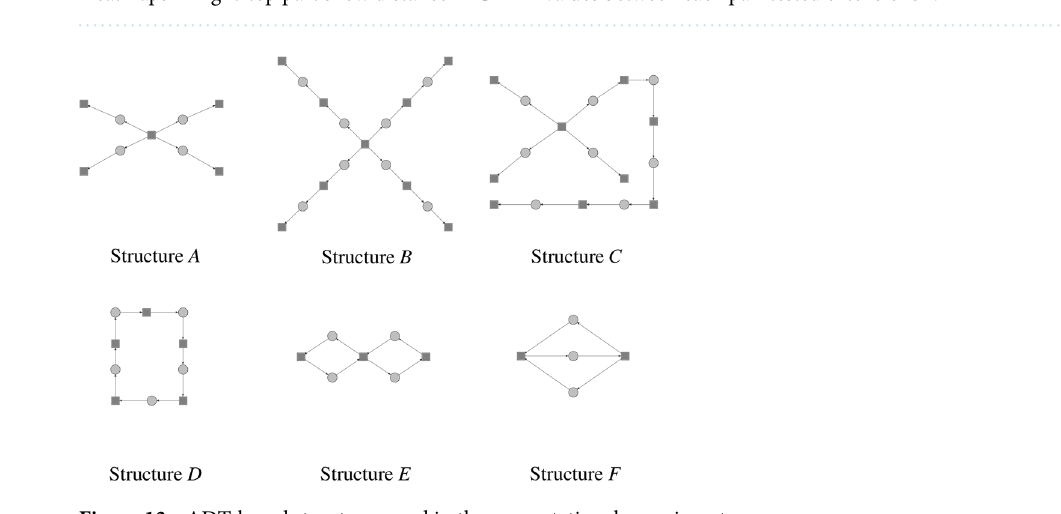
Figure 13. ADT-based structures used in the computational